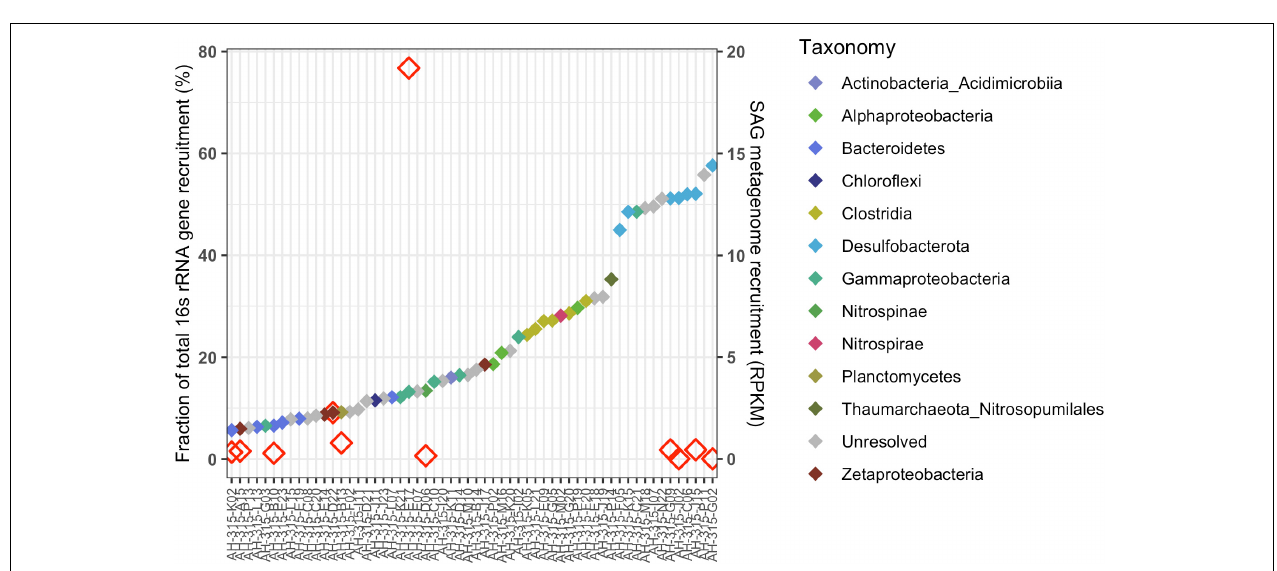
FIGURE 2 | Recruitment of metagenomic (i.e., DNA) and metatranscriptomics (i.e., RNA) sequence reads from all North Pond Hole U1382A and Hole U1383C horizon fluid samples (i.e., from Seyler et al., 2020) from multiple years (indicated by color per legend) to low-coverage single cell amplified genomes (SAGs) from Hole U1383C Deep horizon collected in 2017. Mapped reads were filtered to those with > 95% ID to SAG sequences. Metatranscriptomic data includes both mRNA and rRNA mapping to ribosomal genes. The boxes represent the inter-quartile range (25th–75th quartiles) and the horizontal line inside the box is the median.